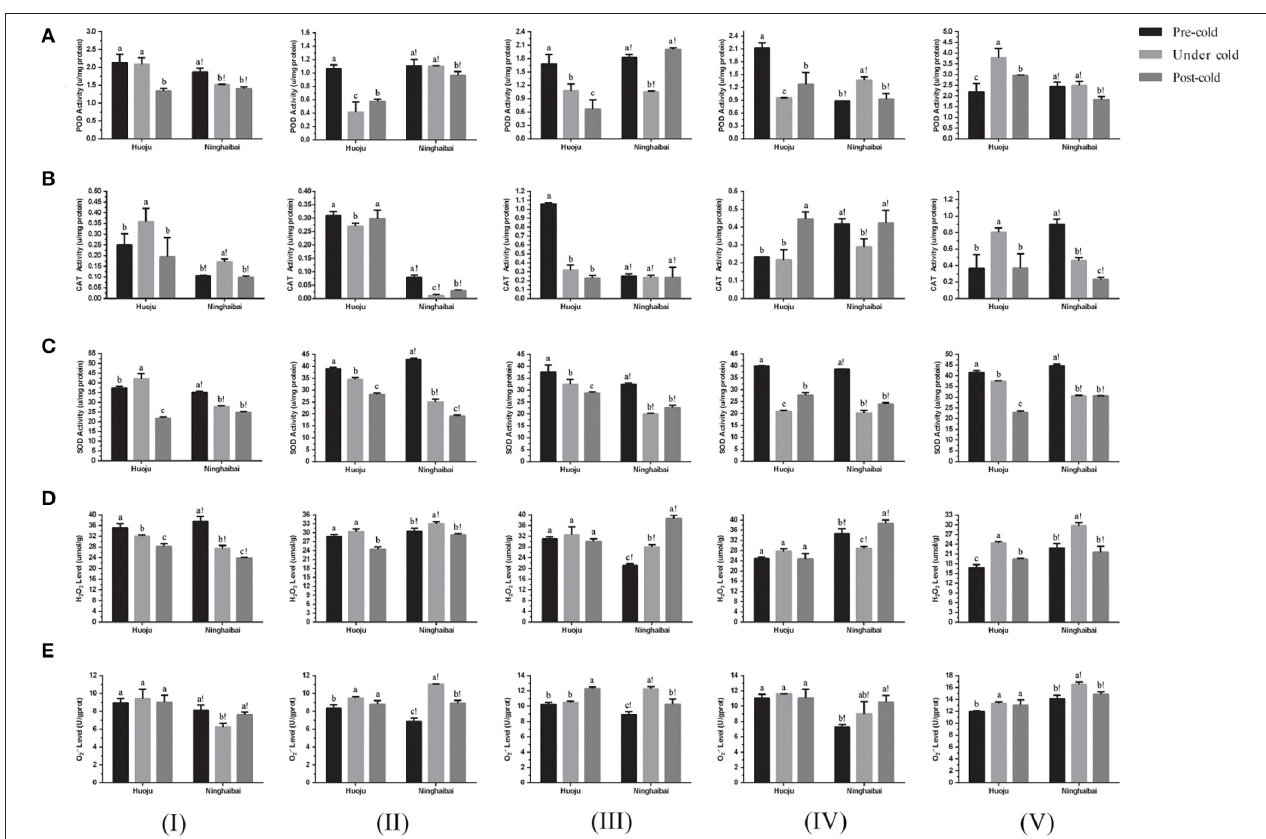
FIGURE 3 | Changes in activity of antioxidant enzymes POD (A) , CAT (B) , and SOD (C) and level of H 2 O 2 (D) and O − 2 (E) in different organs of two loquat varieties. I–V in the graph indicates sampling organs, including showing-white flower, blooming flower, unclosed calyx, closed calyx, and rachis. Different letters indicate the significance at p < 0.05, out of which a, b, and c indicate the significant difference of “Huoju,” whereas a!, b!, and c! indicate the significant difference of “Ninghaibai.” Error bars indicate the standard deviation based on three